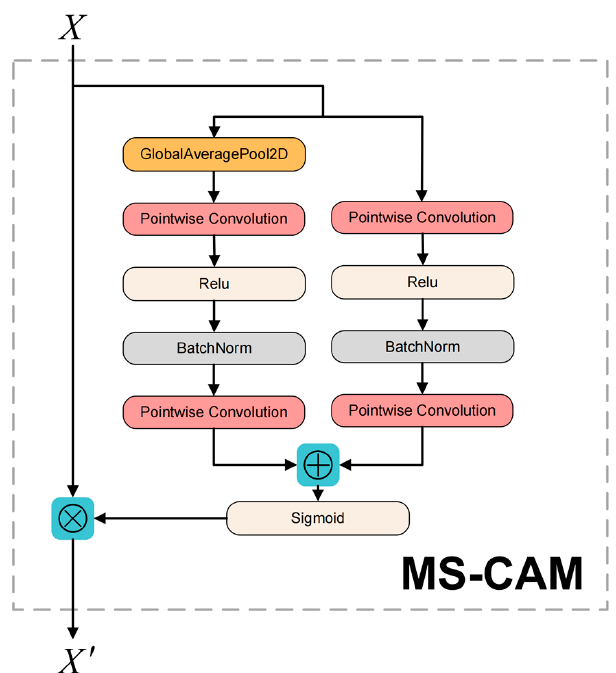
Figure 6. Structure of the MS-CAM module.